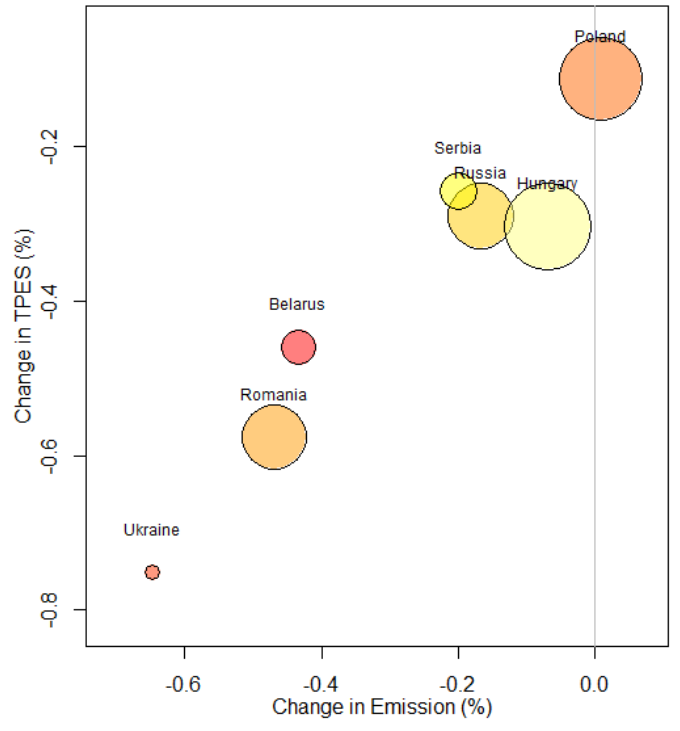
Figure 3. Change in TPES and emissions during the estimation